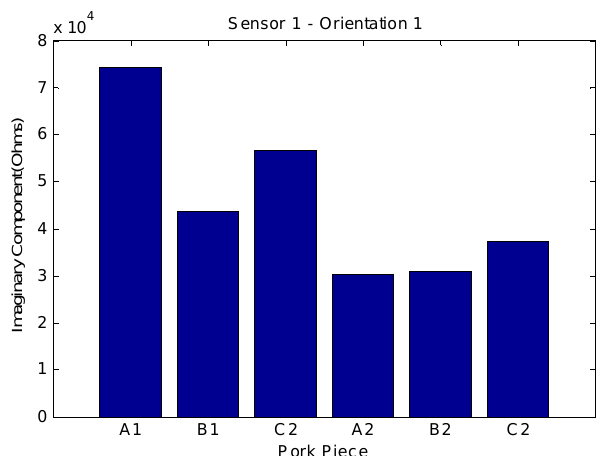
Figure 40. Sensor 1 characteristics at 5 kHz for pork belly samples at orientation 1.